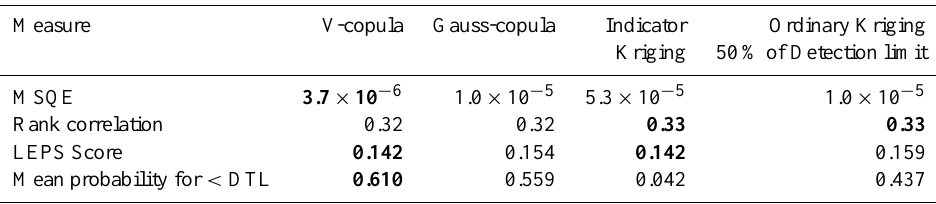
Table 3. Cross validation results for